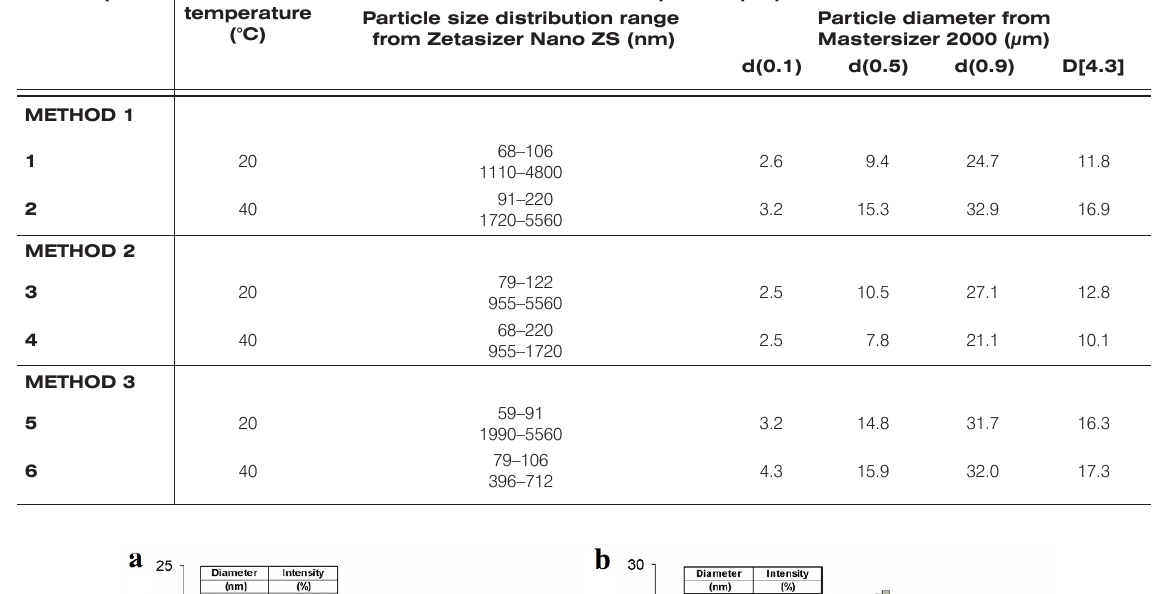
Table 3. Dispersive characteristic of silica/lignin biocomposites obtained by different methods.